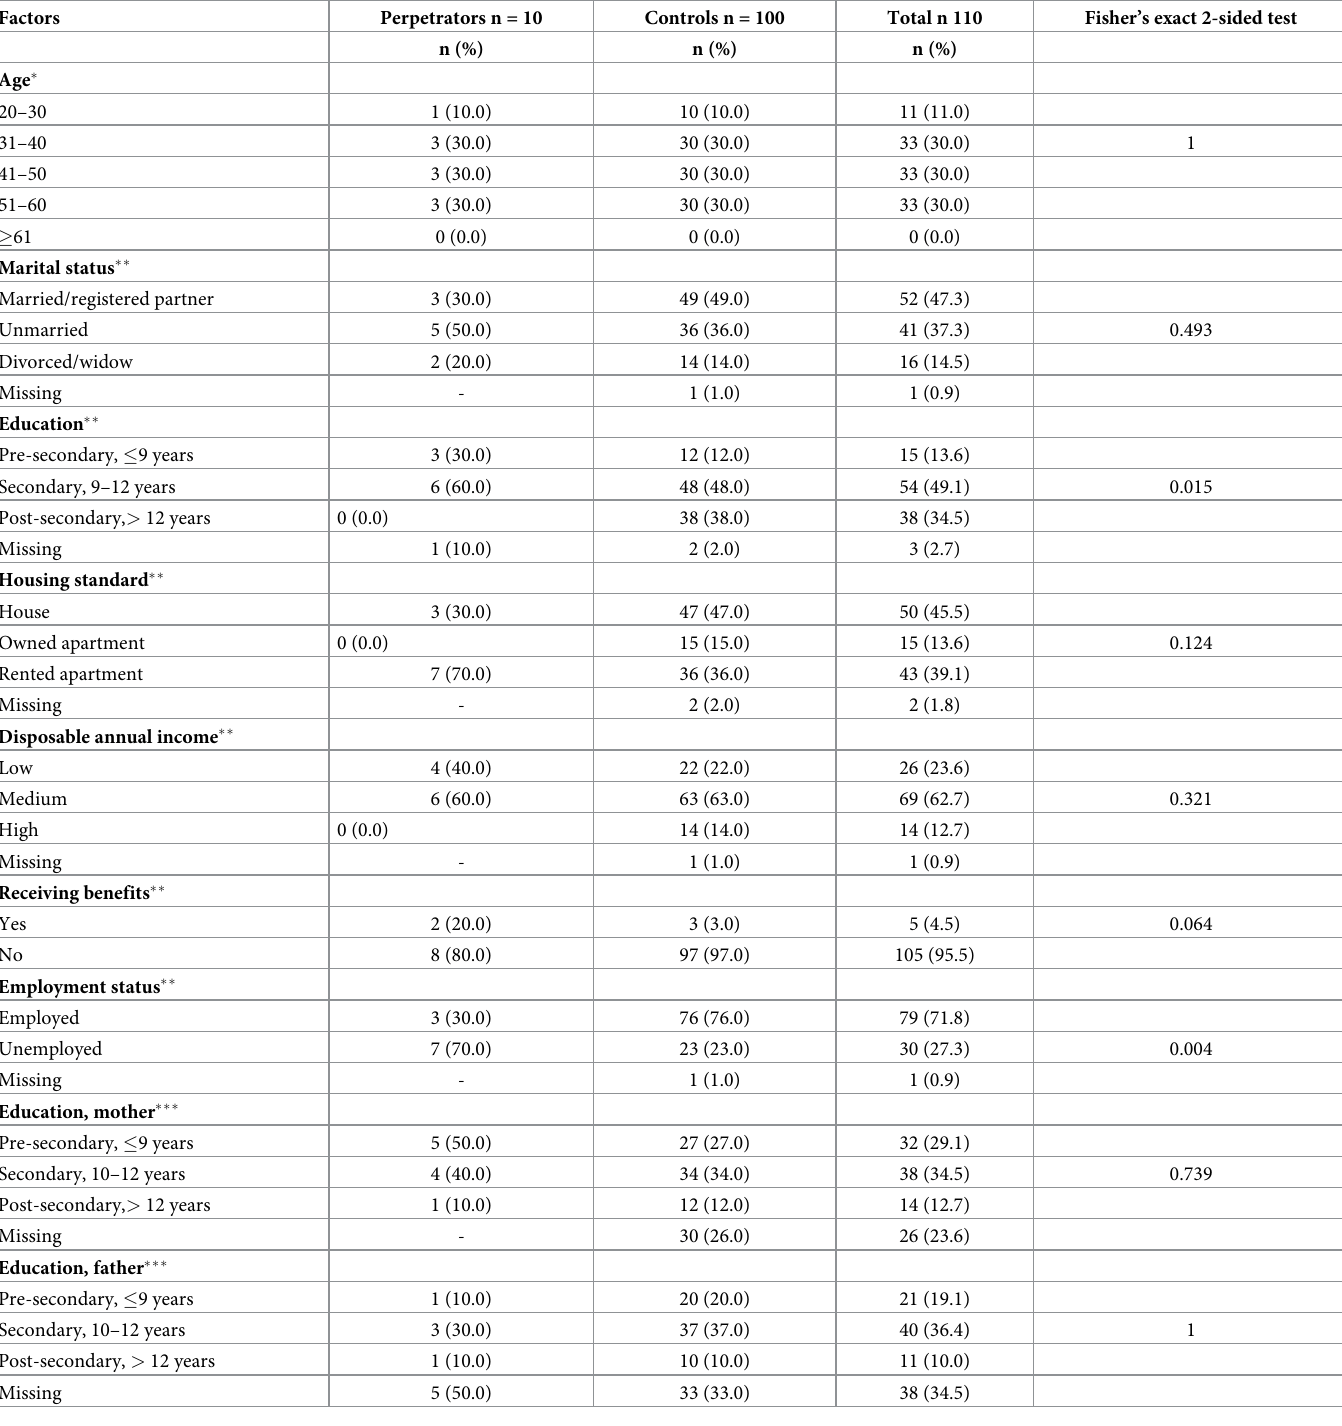
Table 4. Socio-demographic characteristics of female perpetrators, female controls and total population. N = 110; 10 perpetrators and 100 controls.